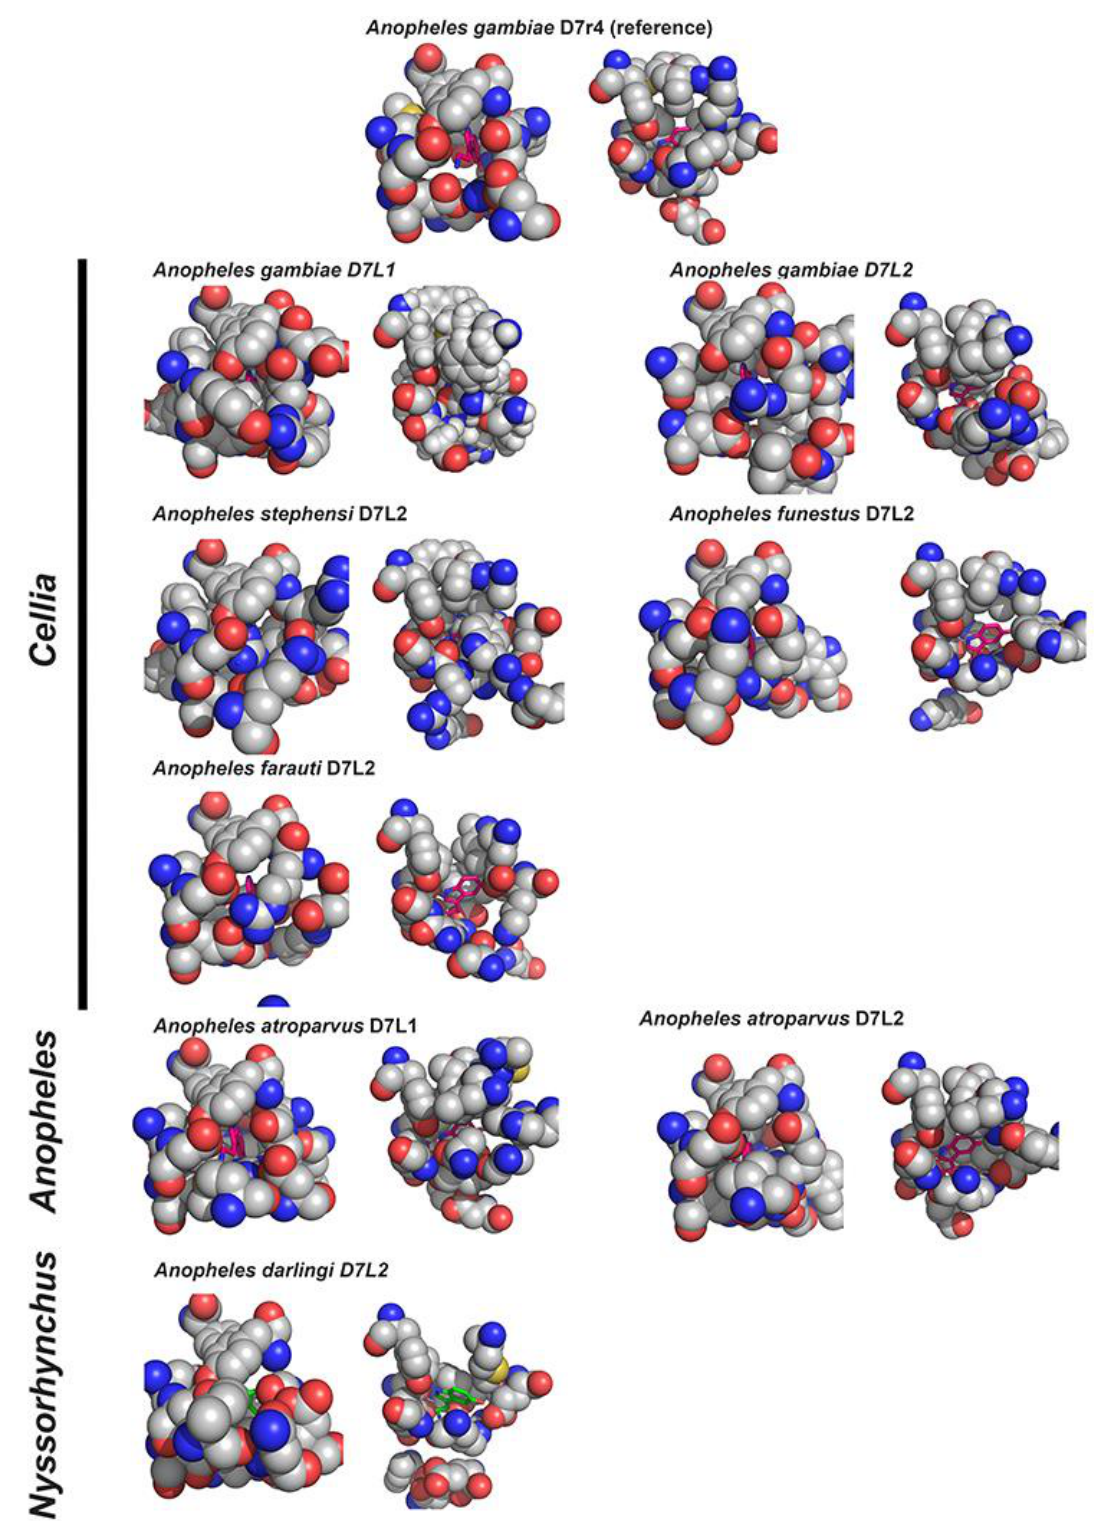
Figure 5. Space -filling model representation of An. gambiae D7r4 biogenic amine binding site and C-terminal domain of D7L1 and D7L2 proteins from Anopheles species representing distinct sub genera and series — Solved structure of Anopheles gambiae D7r4 bound to serotonin (PDB: 2QEH) was used as a reference, and D7L2 and D7L1 (when present) structures (modeled or solved) were aligned to the first. Residues lining the binding pockets were assigned and their atoms (hydrogens are omit- ted) are represented as spheres proportional to their atomic radii, colored by element (carbons in grey spheres, oxygens in red, nitrogen in blue and sulfur in yellow). Proteins are shown in 2 different